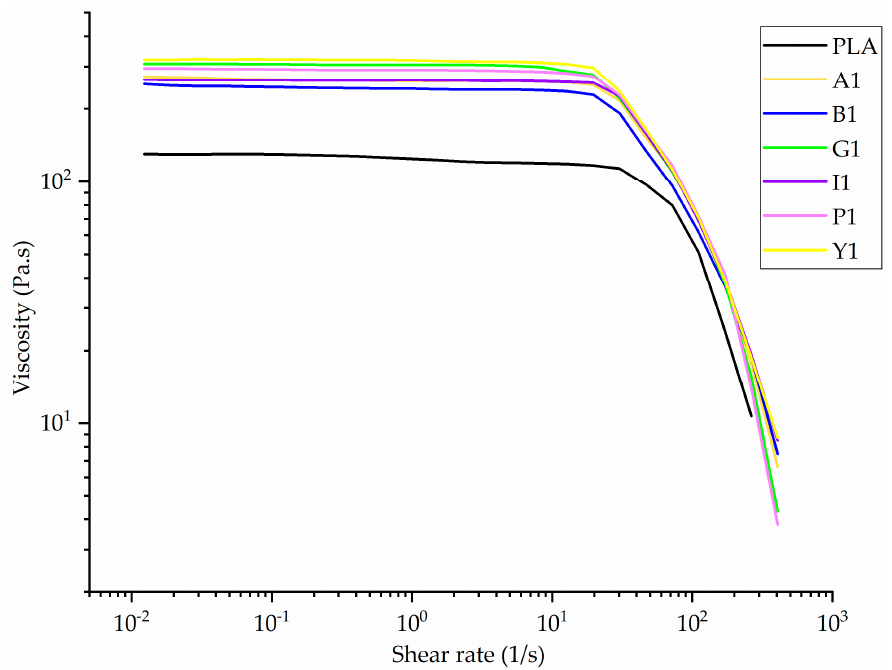
Figure A3. Rheogram of PLA and its composites containing 1% (w/w) of each additive. The rheogram of PLA and the composites containing 1% (w/w) of each additive are presented in Figure A4.